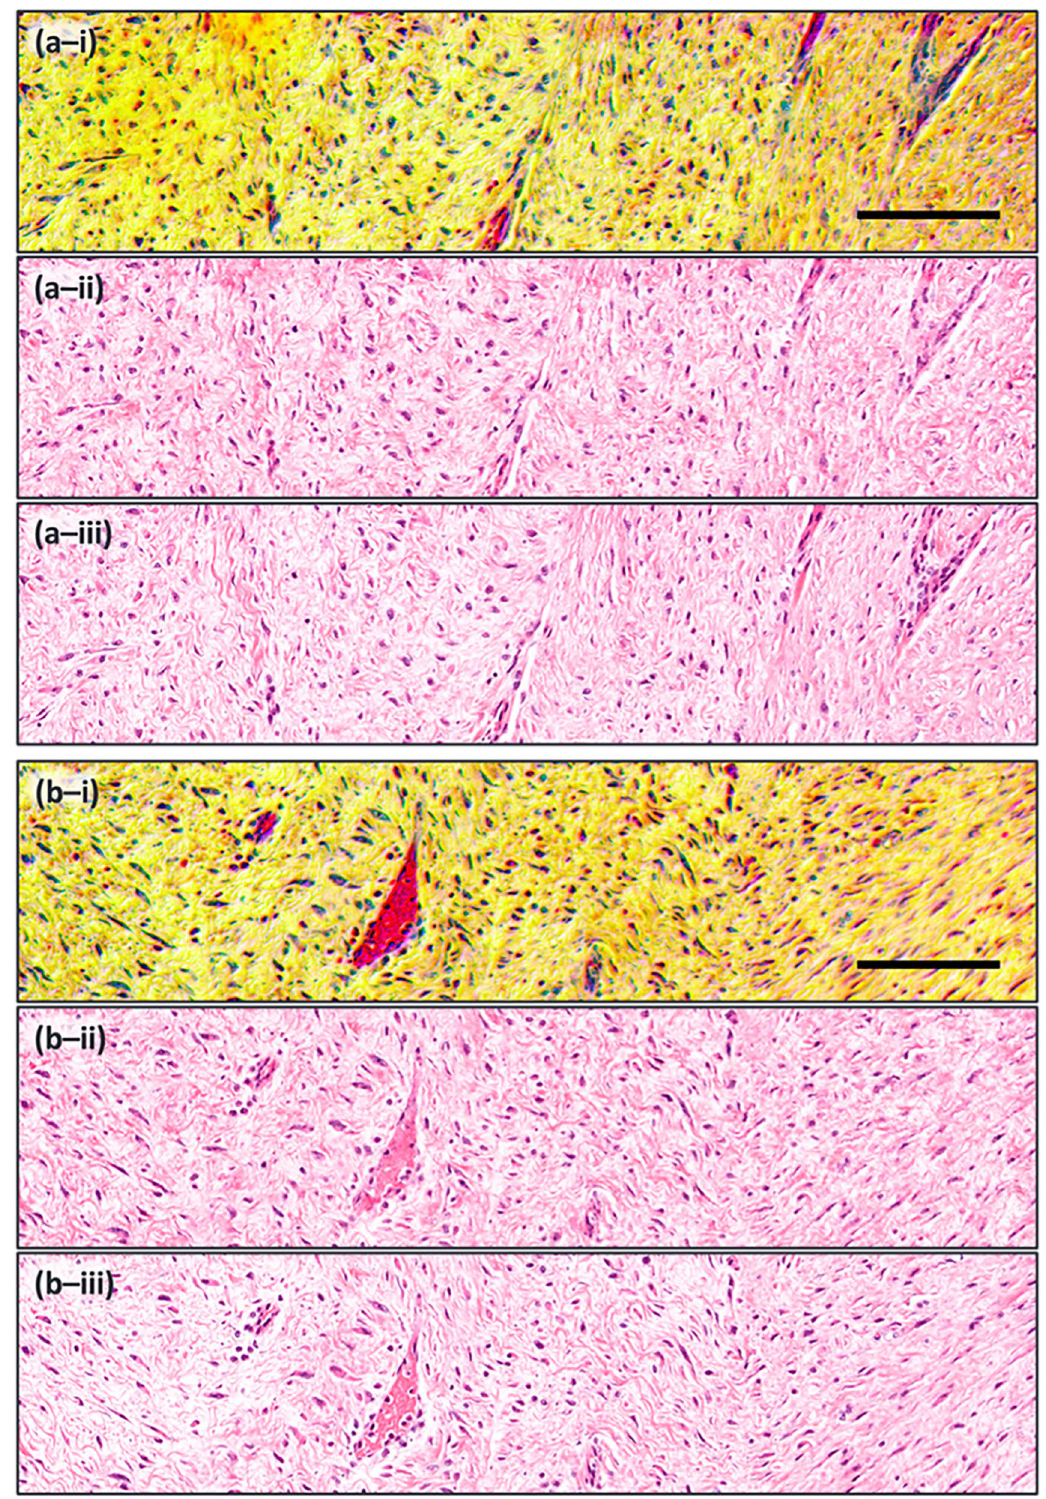
Figure 8. Another set of virtual staining results using unseen data of human skin tissue. Image sets ( a ) and ( b ) show different parts of the dermis like connective tissue and blood vessels. (i) Raw TA-PARS. (ii) H&E-like TA-PARS. (iii) True H&E. Scale bar 100